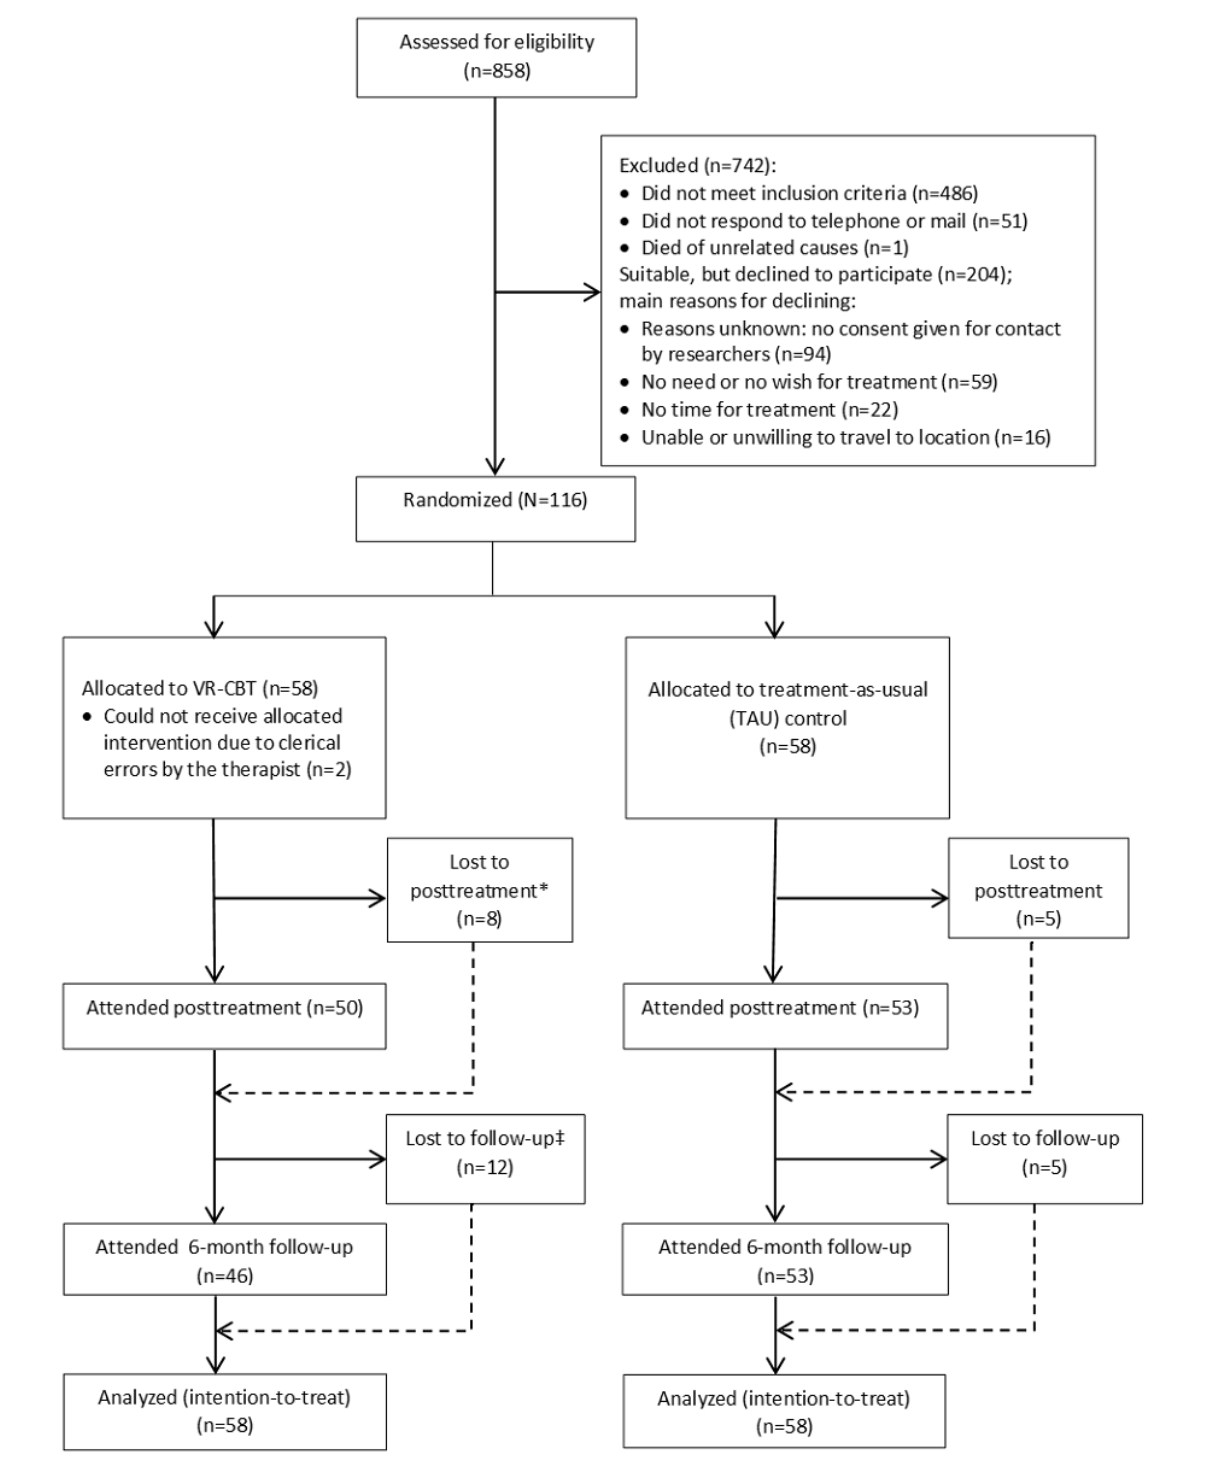
Figure 1. Trial flow diagram. *Specification of participants lost to posttreatment: 6 declined further participation and 2 were lost due to clerical errors by therapist. ‡Specification of participants lost to follow-up: 9 declined further participation, 1 died of unrelated causes, and 2 were lost due to clerical errors by therapist. First published in Lancet Psychiatry (Pot-Kolder et al, 2018). VR-CBT: virtual reality-based cognitive behavioral